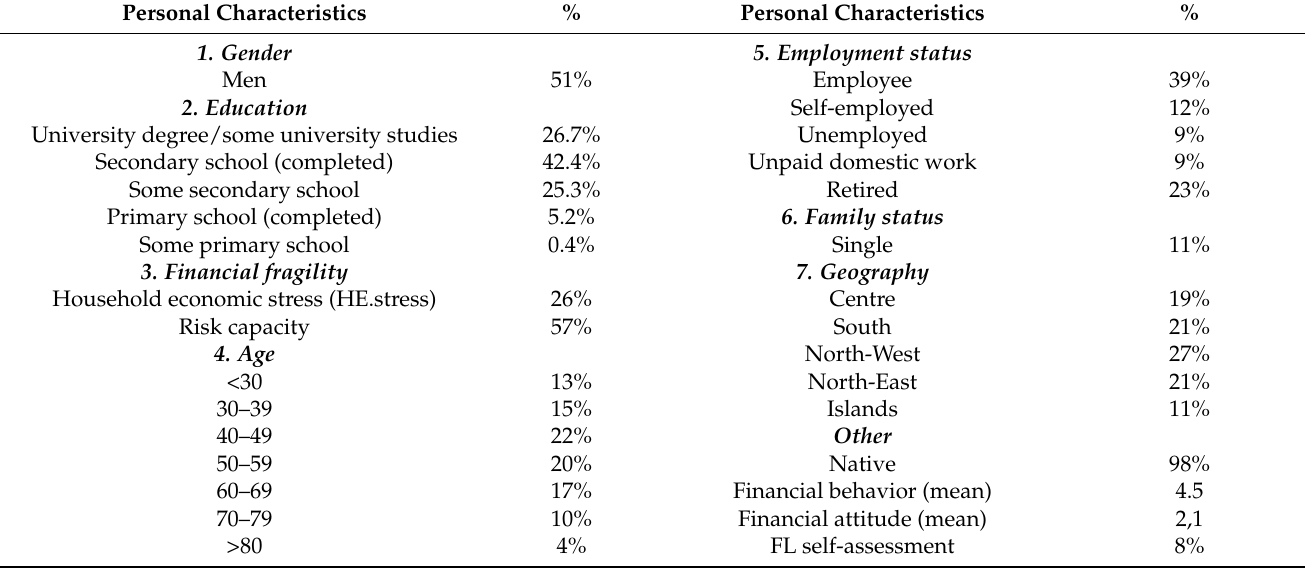
Table 1. Main characteristics of adult Italians with higher financial knowledge than